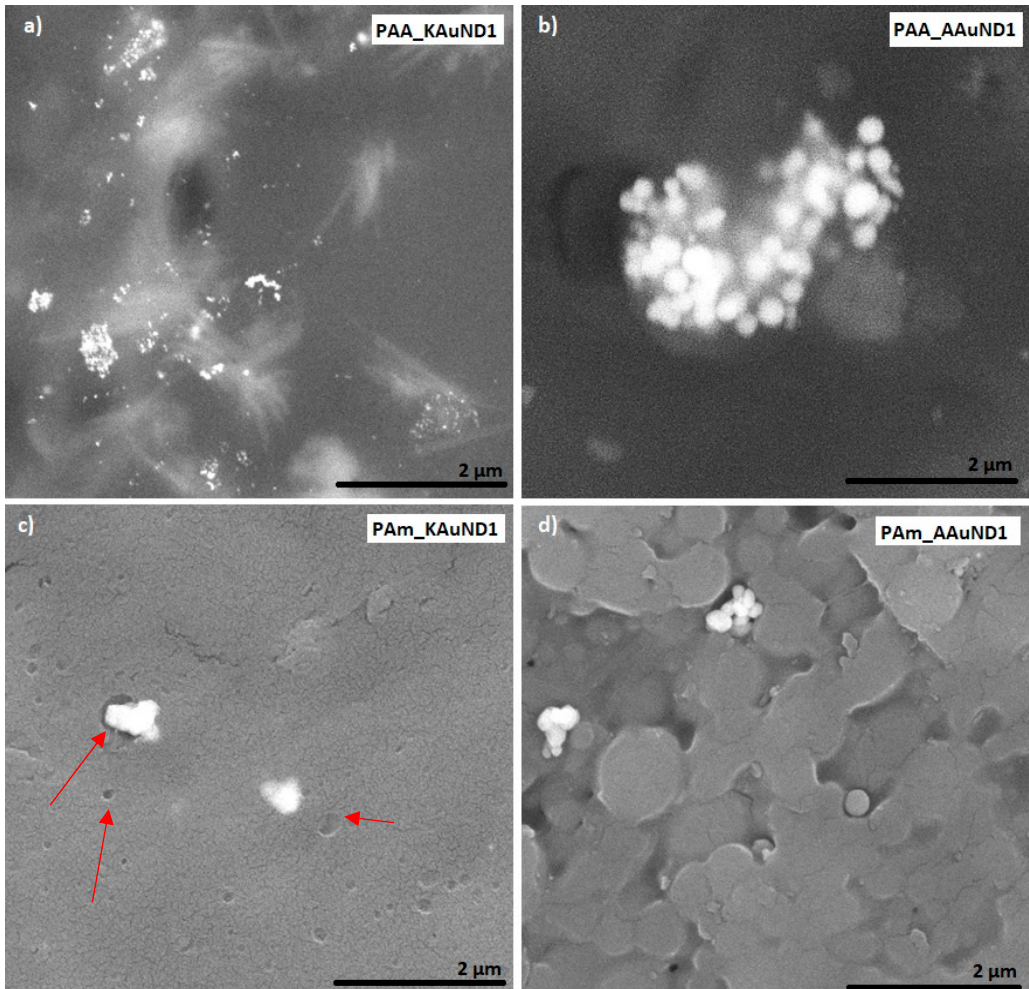
Figure 5. SEM images of prepared polyacrylate-AuNPs’ composites with AuNPs from gold chloride: ( a ) PAA_KAuND1; ( b ) PAA_AAuND1; ( c ) PAm_KAuND1 and ( d ) PAm_AAuND1. The arrows indicate the locations of the microporosity, where AuNPs are located.